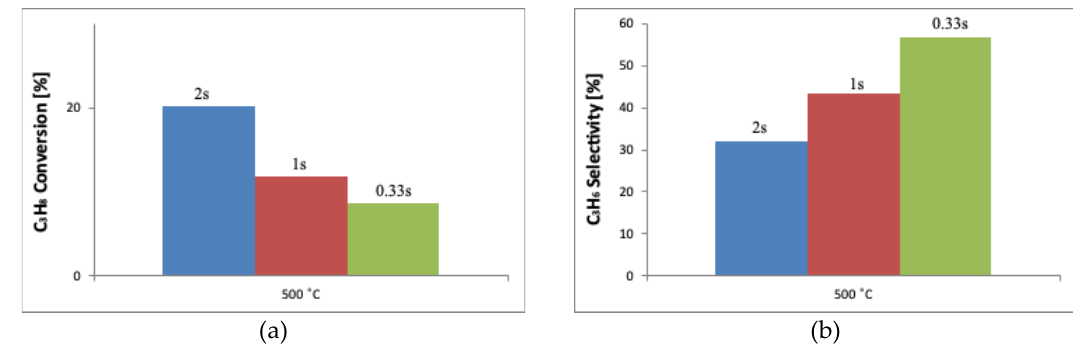
Figure 7. The conversion of propane ( a ) and selectivity to propene ( b ) as a function of the contact time (data plotted for the V 6.0 FAUdes catalyst for T = 500 ◦ C). Figure 8. Selectivity to propene as a function of the reaction temperature.